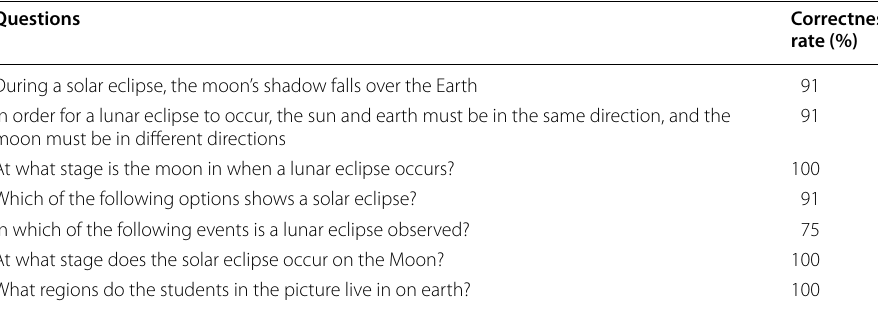
Table 2 Correctness rates on the achievement test